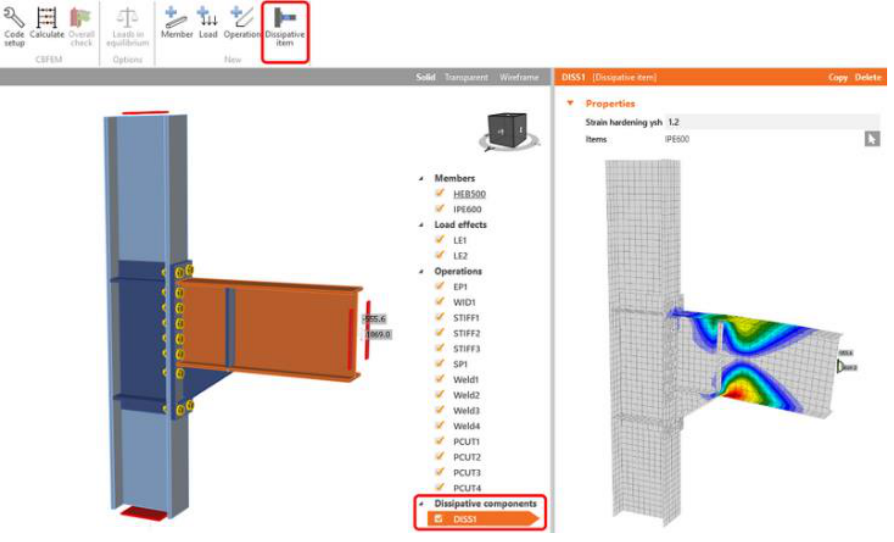
Figure 15. Idea Connection software sample.